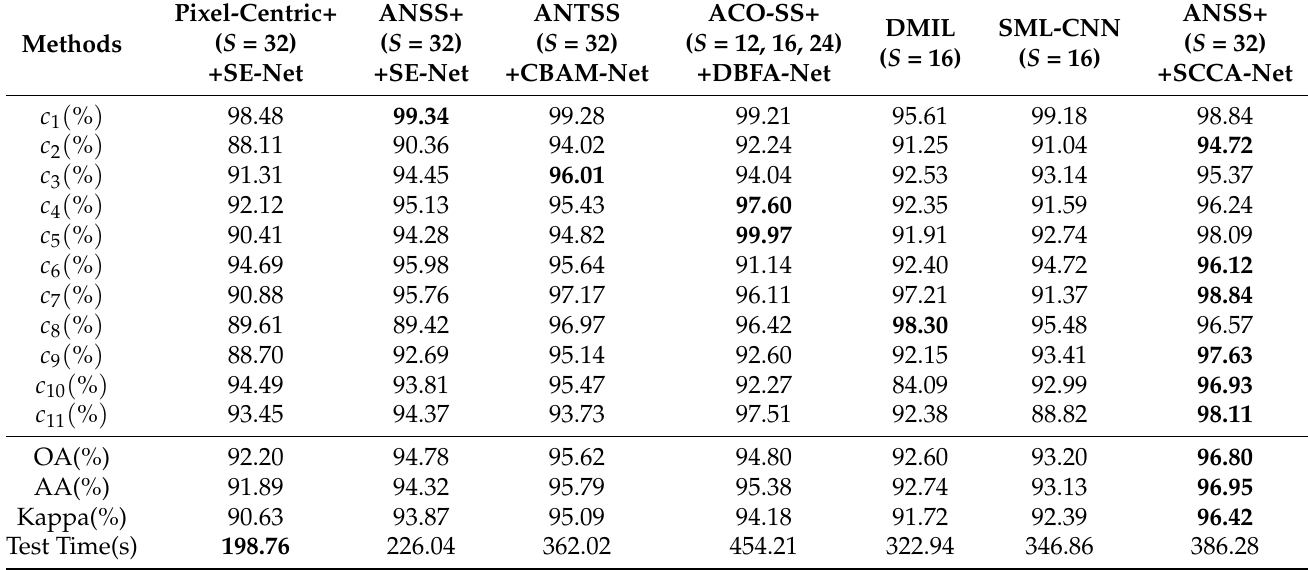
Table 5. Quantitative Classification Results of Huhehaote Level 1A